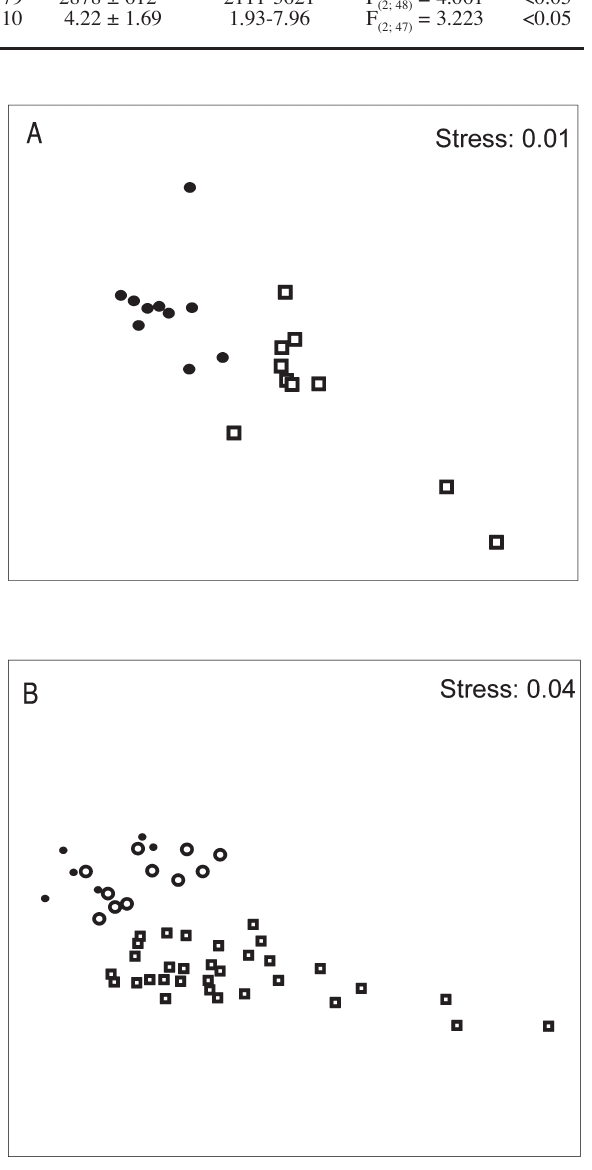
F IG . 3. – nMDS ordinations of multi-element composition for (a) striped weakfish (b) whitemouth croaker collected at coastal sites.( (cid:2) ) Partido de La Costa, ( (cid:3) ) Mar del Plata and ( (cid:4) ) San Blás